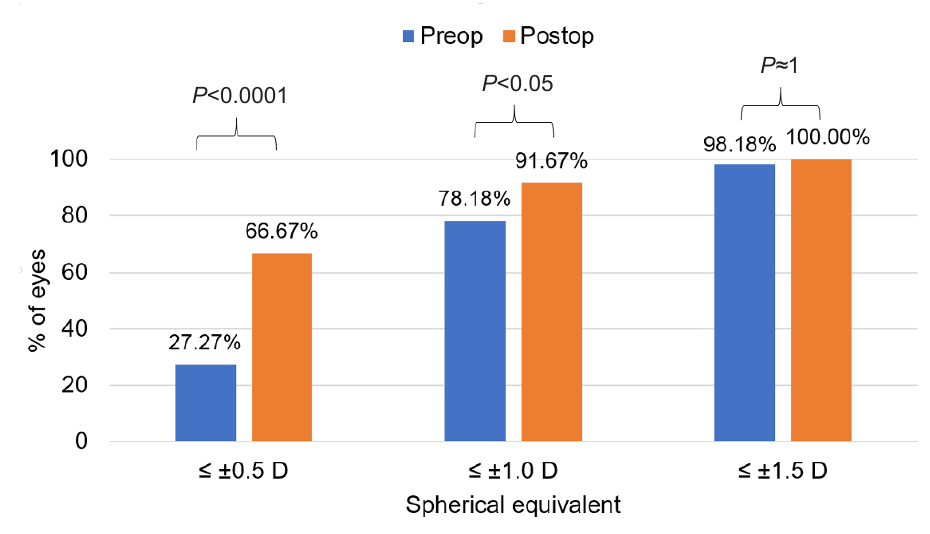
Fig. 1. Evaluation of spherical equivalent before and after laser enhancement.